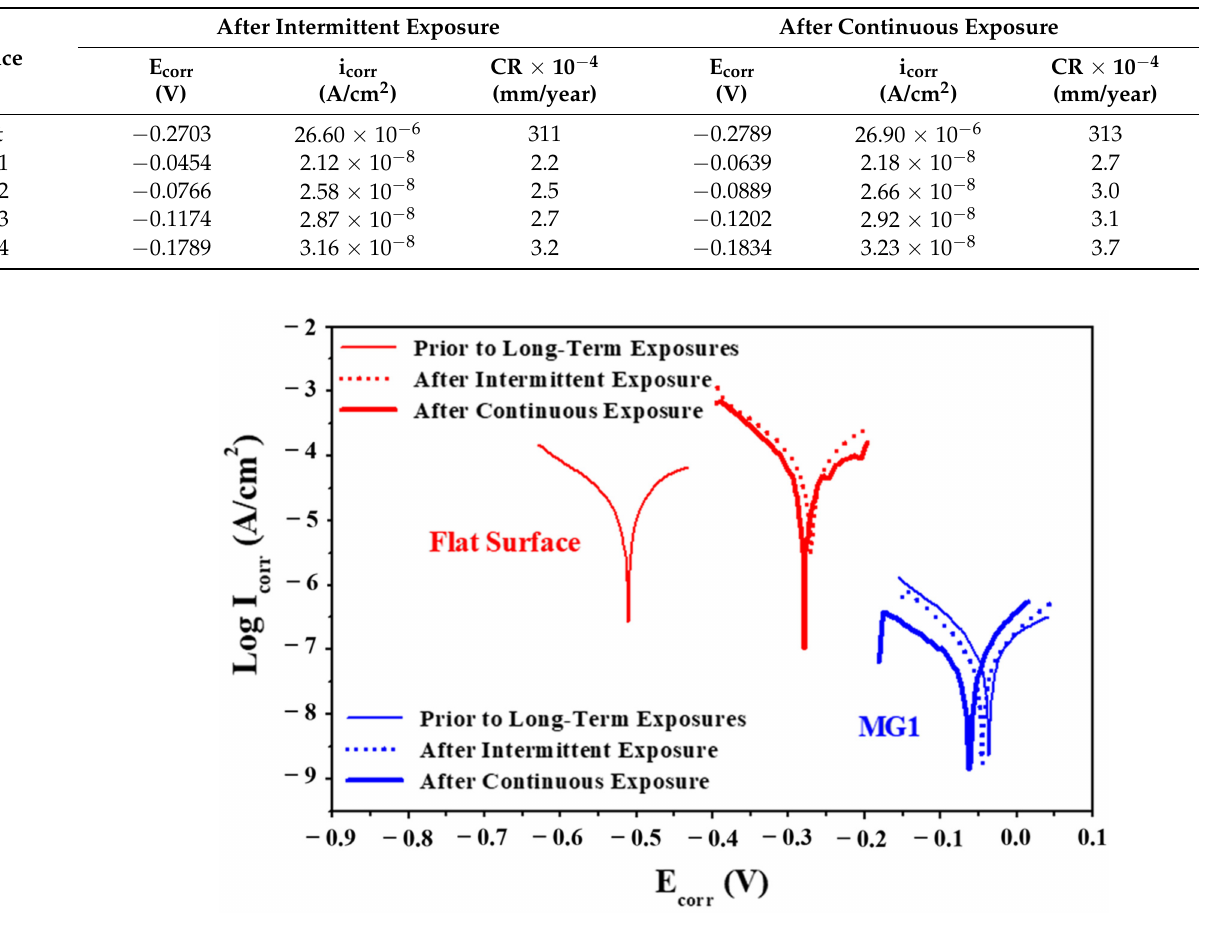
Figure 6. Tafel plots of the flat surface and MG1, prior to long-term exposures, after intermittent exposure and after continuous exposure, to 3.5 wt. % NaCl